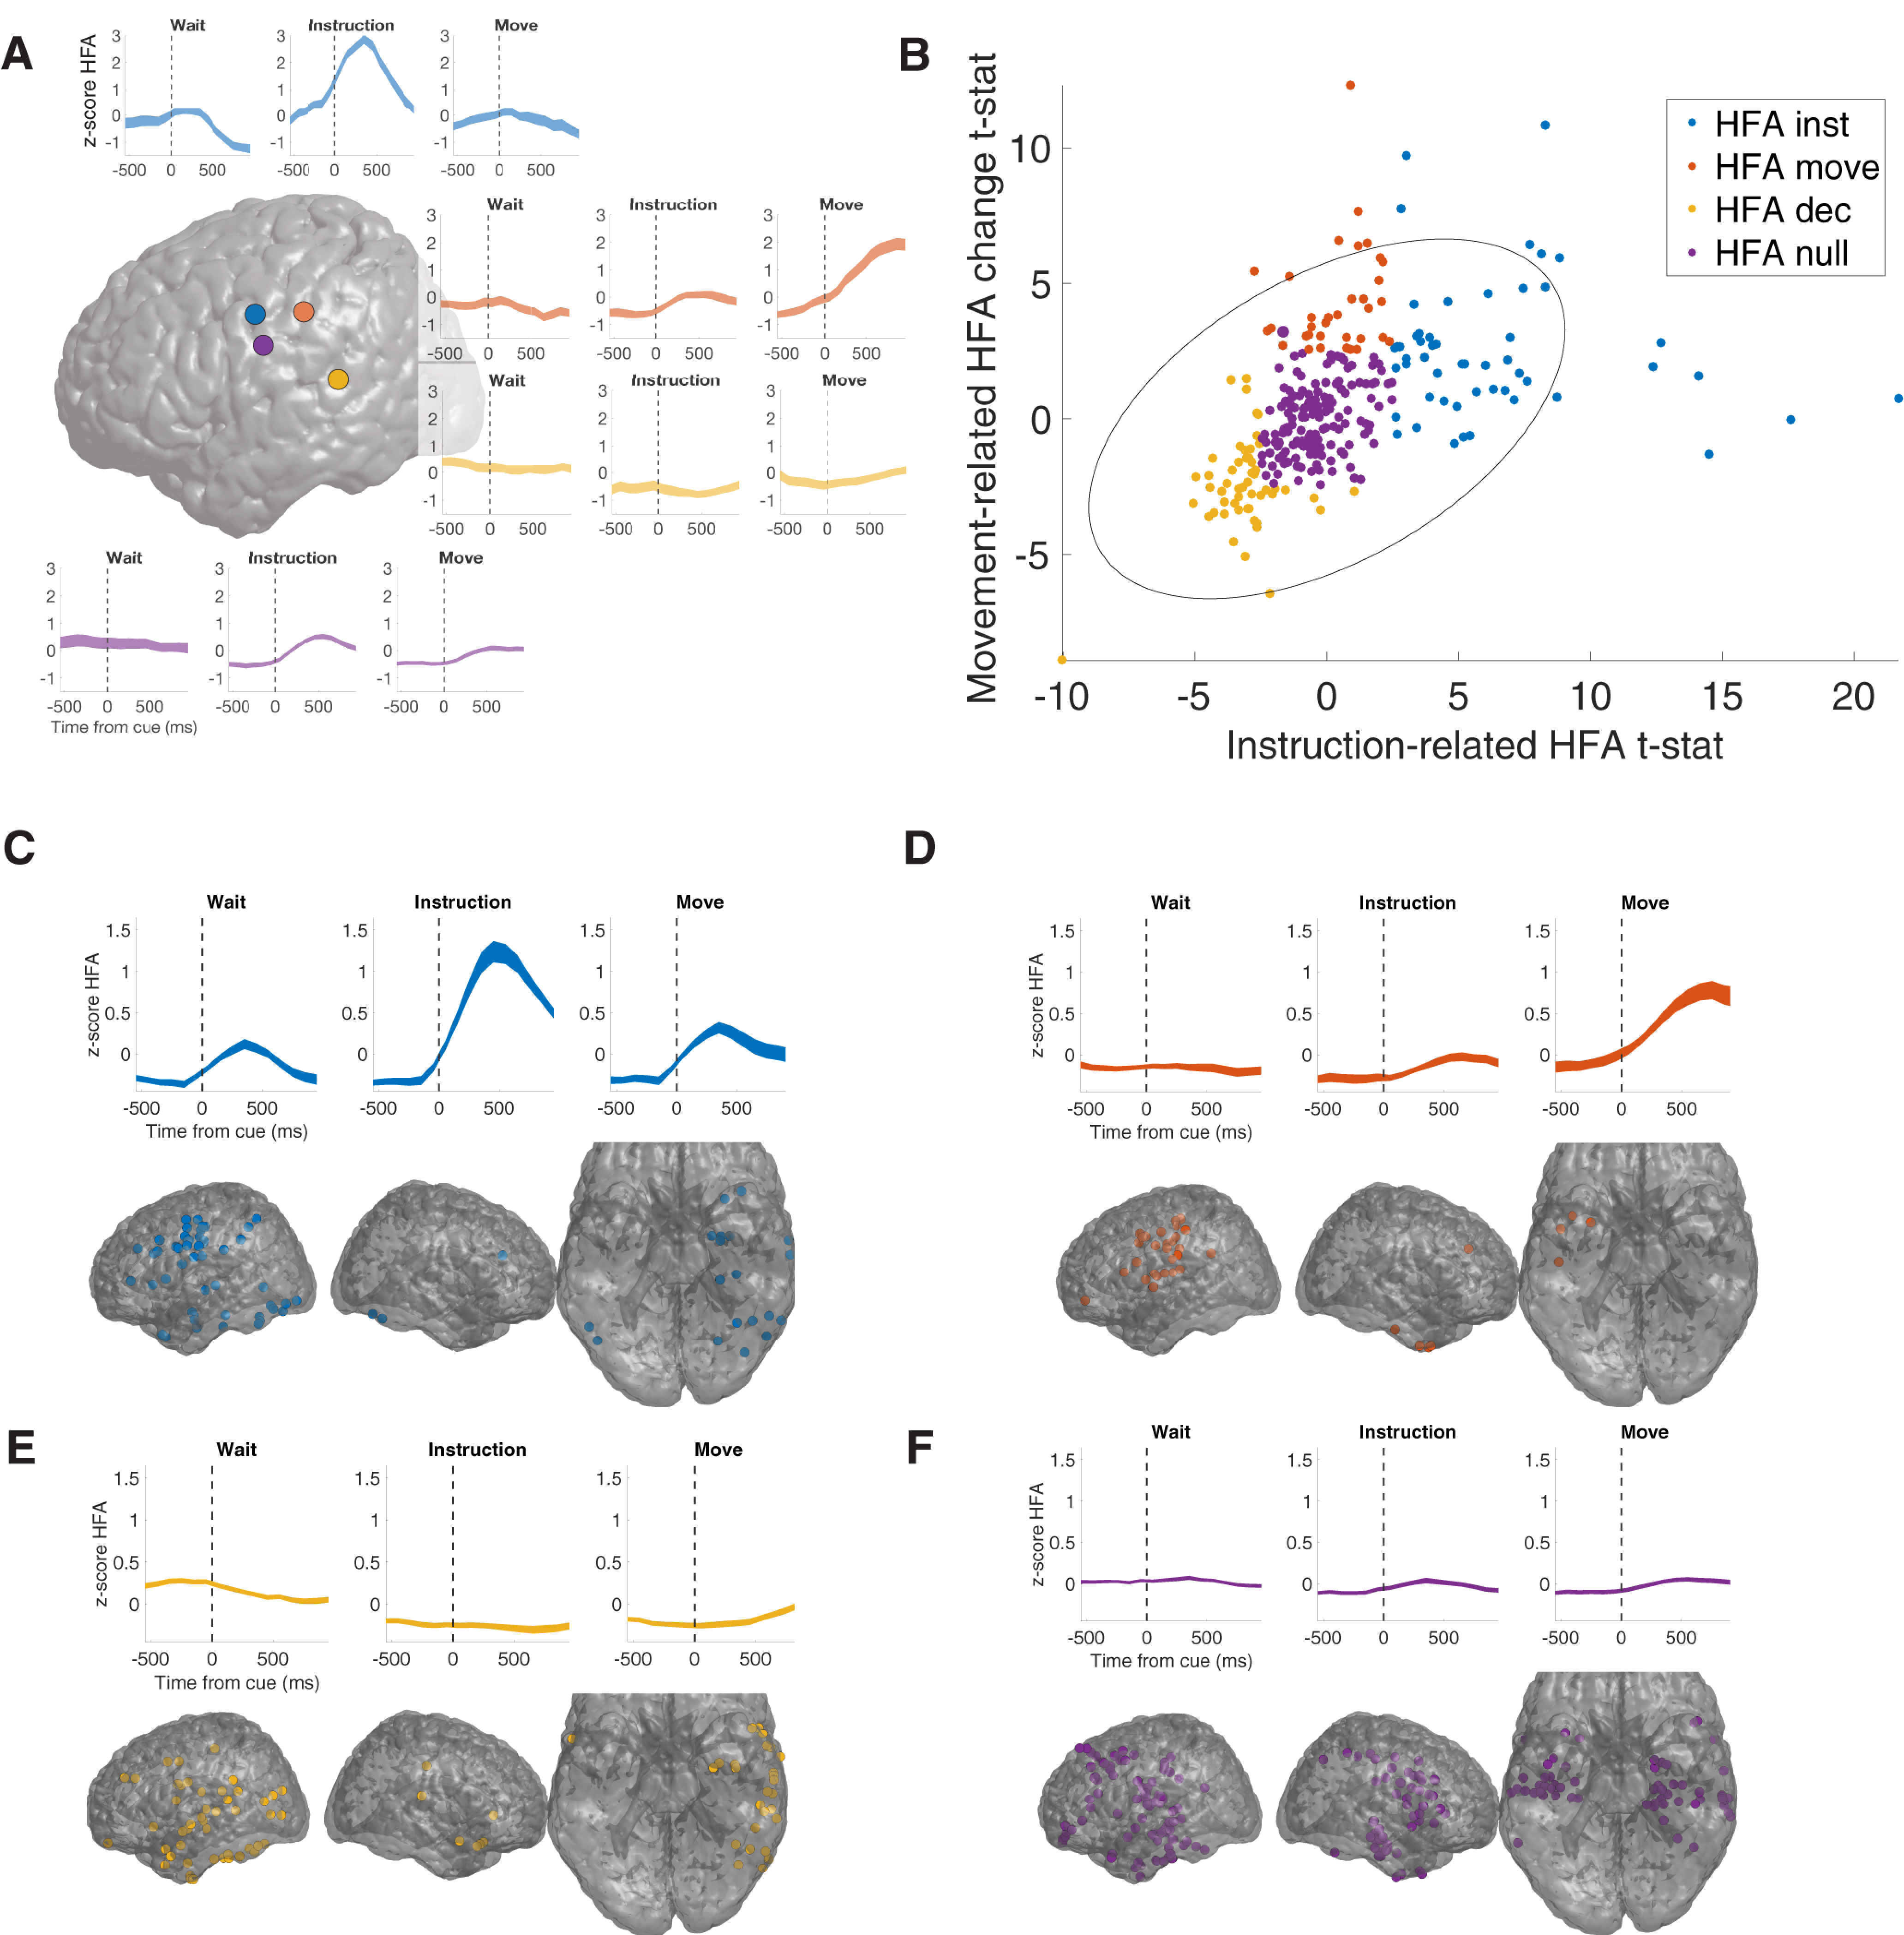
HFA identifies distinct local neural responses. A, Four example electrodes showing distinct HFA responses during the task from the same subject. Brain plot illustrates the location of each electrode (purple, blue, and orange are in perirolandic, whereas yellow is parietal, on the border between postcentral gyrus and superior temporal sulcus). The HFA responses in each of these electrodes correspond to the average response functions described below. B, Distribution of instruction and movement-related HFA across all electrodes (see main text for details). We identified four groups of electrodes as follows: (1) Instruction-related electrodes (blue, 53 electrodes, 7 subjects), (2) Movement-related electrodes (red, 34 electrodes, 6 subjects), (3) HFA decrease (yellow, 54 electrodes, 8 subjects), and (4) HFA null (purple, 147 electrodes, 9 subjects). Gray error ellipse marks 95% confidence interval of bivariate distribution. C–F, Average HFA (z-scores) at each electrode group and their anatomic distributions on brain plots.